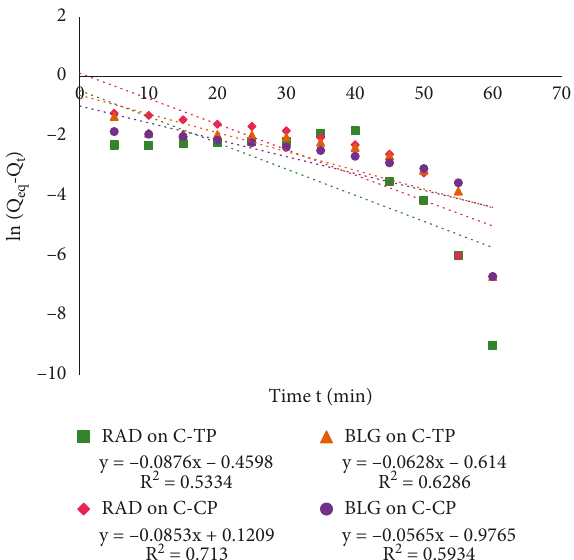
Figure 17: A comparative evaluation of the pseudo-first-order kinetics for the adsorptive dye removal performance of acid-treated biosorbents. Initial pH � 5, final pH for RAD on C-TP and C- CP � 4, BLG on C-TP � 4.5, and BLG on C-CP � 4. (b) Pseudo- second-order